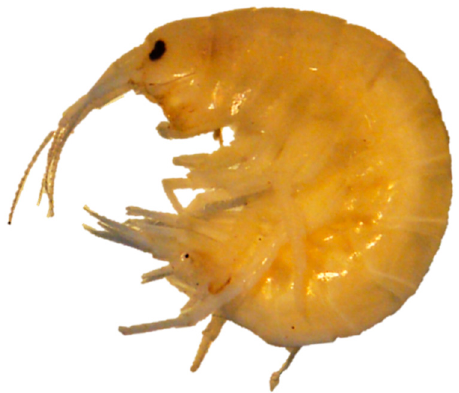
Figure 10. Example of amphipod species that can be used for ecotoxicity assessment: Gammarus sp.